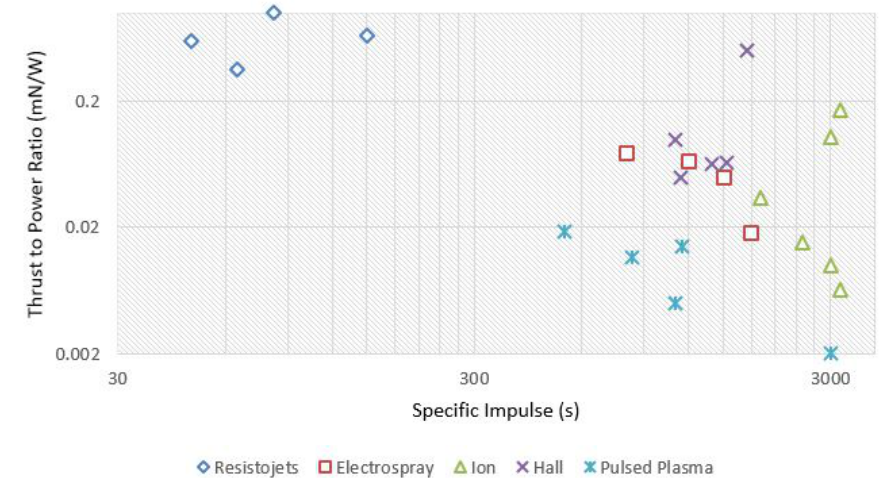
Figure 11. Thrust to Power Ratio vs. Specific Impulse for Electric Propulsion Systems from